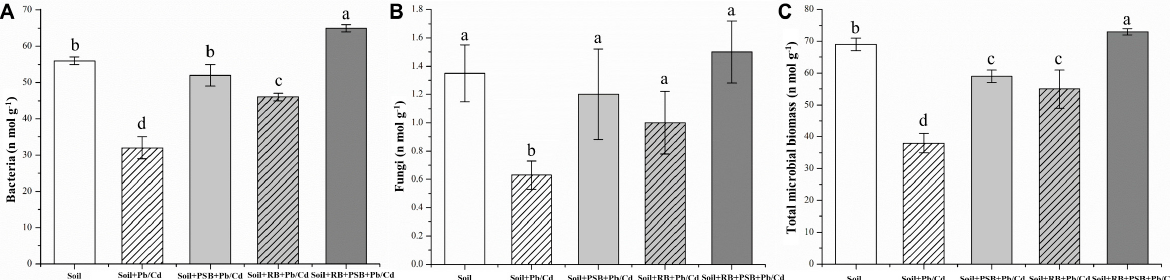
Figure 2. Microbial biomass of microorganisms in soils with different treatments (( A ): Bacteria bio- mass, ( B ): Fungi biomass, ( C ): Total microbial biomass, RB—rice husk biochar, PSB— Enterobacter sp.). Different letters indicate significant differences among treatments.